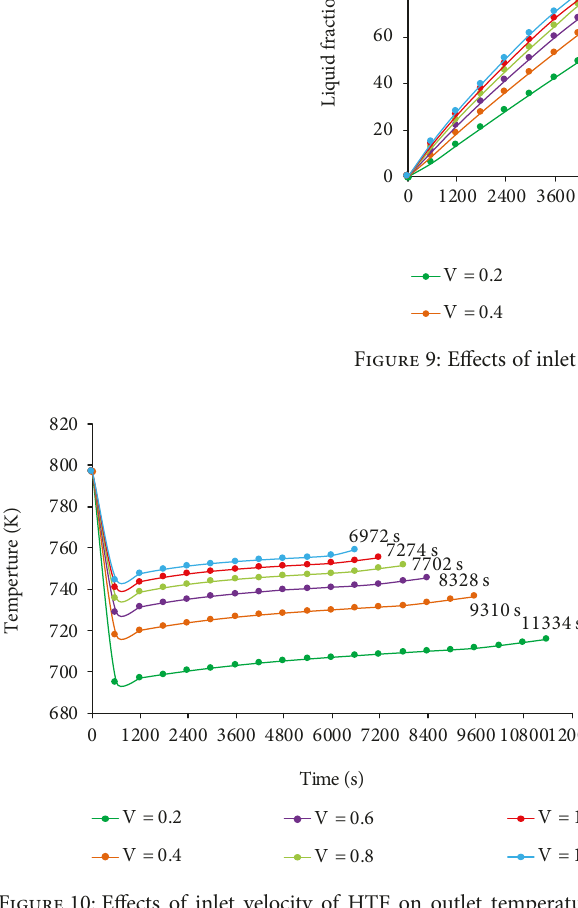
Figure 10: E ff ects of inlet velocity of HTF on outlet temperature of